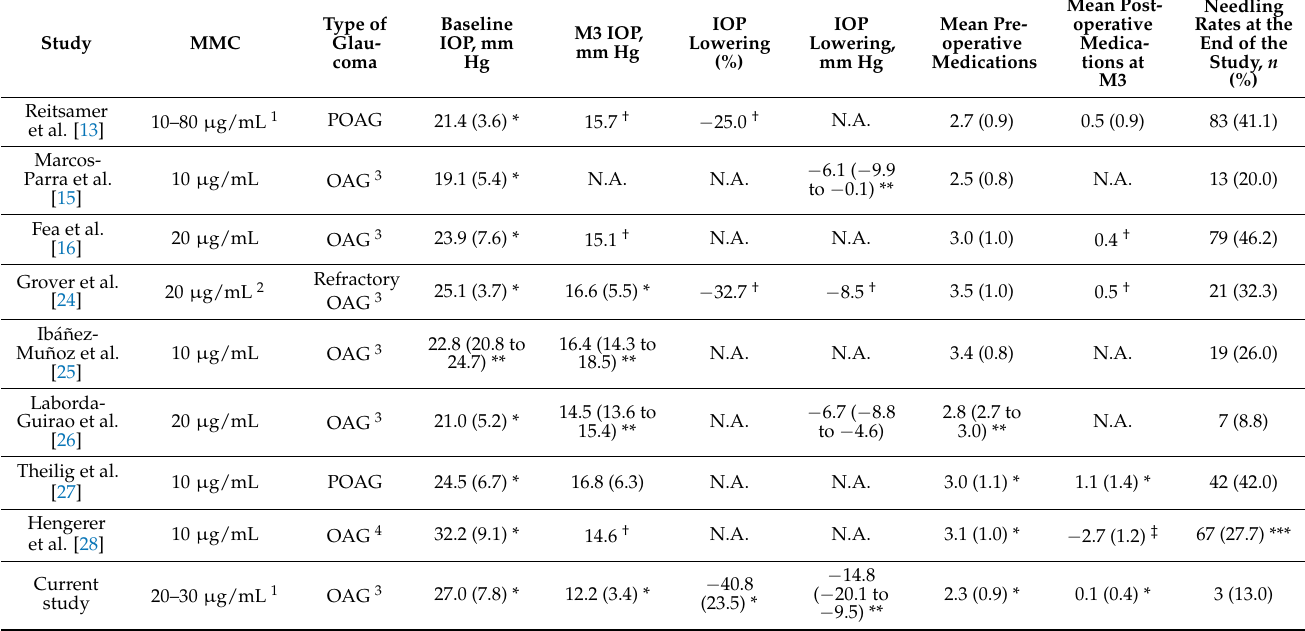
Table 3. Overview of the intraocular pressure (IOP) and number of hypotensive medications in eyes that underwent XEN45 implant surgery in different studies at month-3.